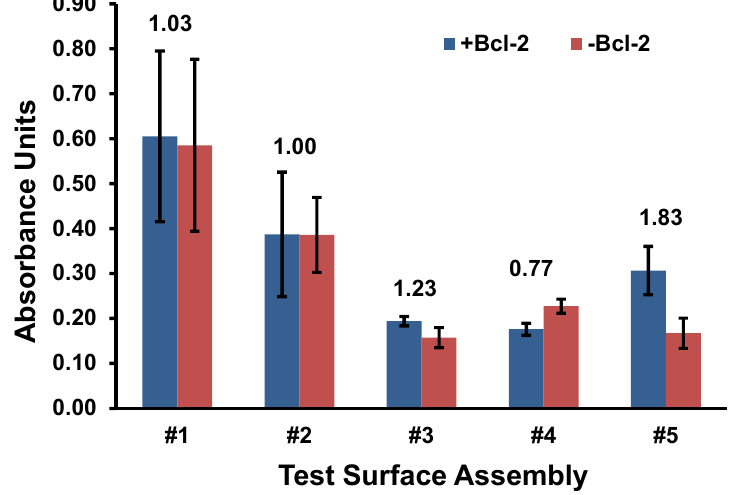
Figure 2. Bcl-2 detection on engineered surfaces was quantified by ELISA. Mean values are presented with error bars representing SEM (n = 3). Signal-to-noise ratios (A are displayed above the bar